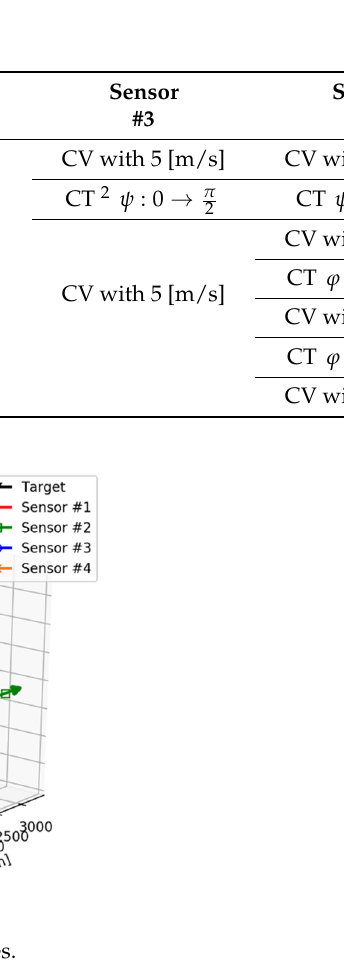
Table 1. Sensor maneuvering scenario.